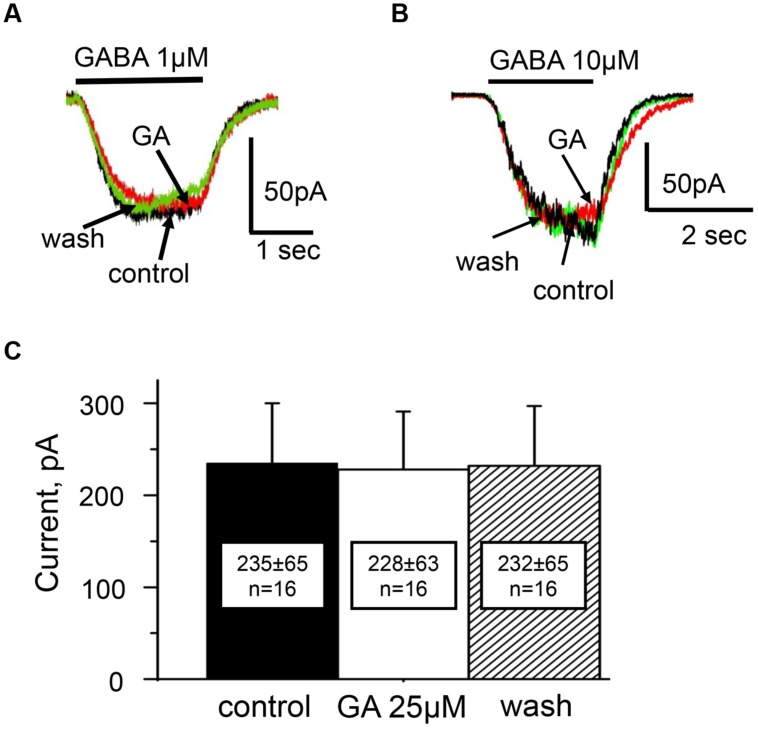
Action of ginkgolic acid on GABA-evoked currents recorded in CHO cells, expressing of GABAA receptors.
(A,B) Superimposed traces of currents evoked by GABA 1 μM (A) and 10 μM (B) in control (black), after ginkgolic acid application (red) and after washout (green). Vh = –30 mV. Symmetrical ‘CsCl’ pipette solution. (C) Summary of the data on the effect of ginkgolic acid on α1/β2/γ2 GABARs. Mean amplitudes of currents (pA) ± SEM induced by 10 μM GABA from 16 cells in control (black), during ginkgolic acid application (white) and after washout (striped).